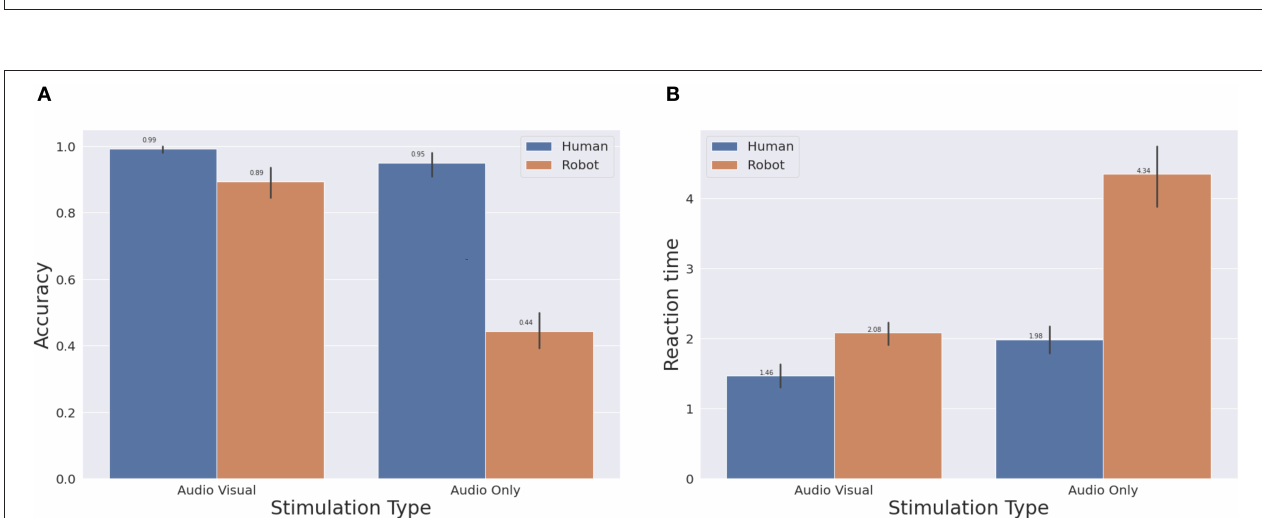
FIGURE 8 | Overall performance across the different types of stimulation for both the robot and the human participants. (A) Accuracy. (B) Reaction time.